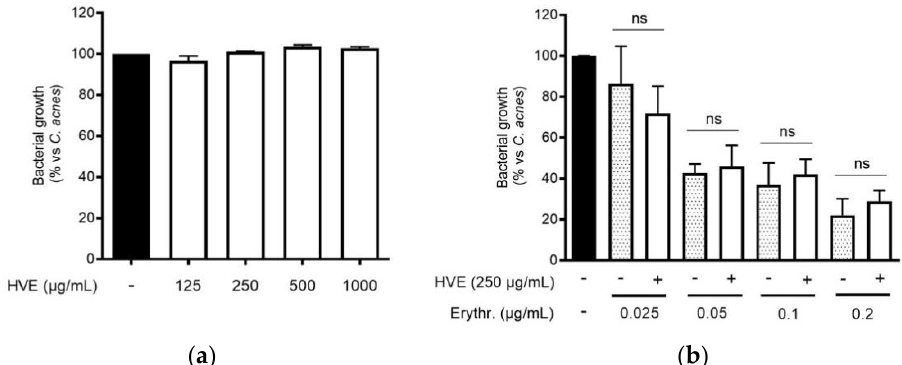
Figure 3. Effect of HVE treatment (125–1000 µ g/mL) on the growth of C. acnes (O.D. = 0.1) for 24 h ( a ). Erythromycin (0.2 µ g/mL) was used as the antibiotic control ( − 80% of growth vs. control). Evaluation of the co-administration of HVE (250 µ g/mL) and erythromycin (0.025–0.2 µ g/mL) on bacterial growth ( b ). HVE + erythromycin not significant (ns) vs. equivalent concentration of